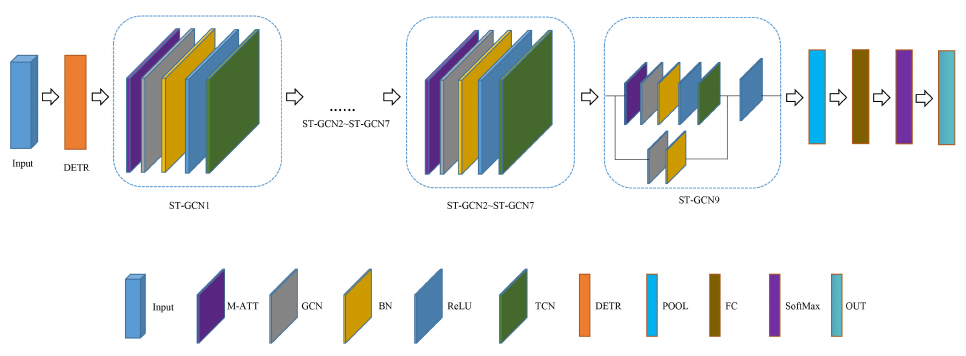
Figure 6. Network structure of the improved ST-GCN.